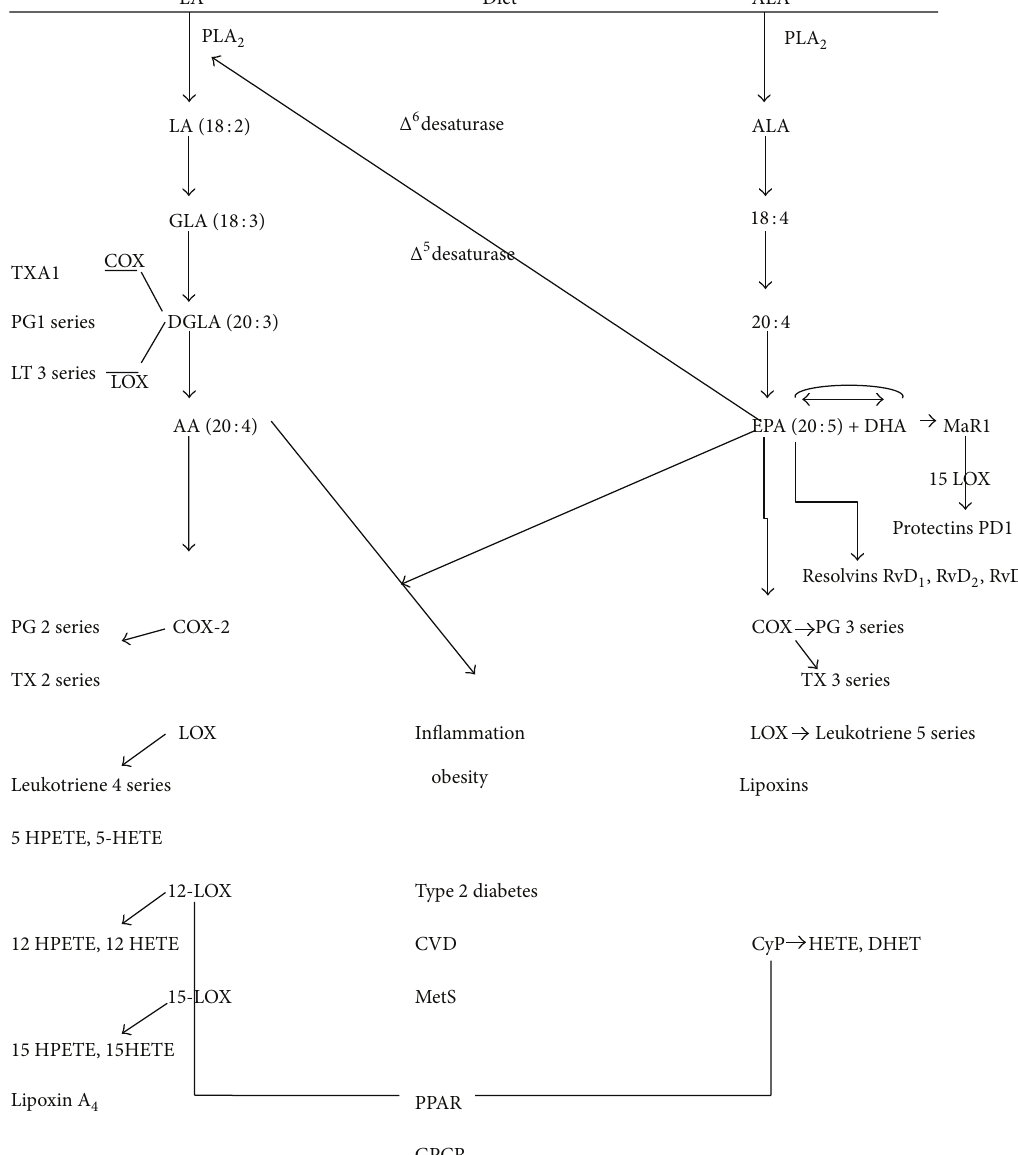
Figure 1: Major lipid influences in the inflammatory cascade. The different lipid molecules influenced by diet modulate the inflammatory cascade resulting in inflammation, obesity, cardiovascular disease, and metabolic syndrome. Dietary linoleic gets converted to the principally important proinflammatory arachidonic acid by the action of several enzymes. Further arachidonic acid by the action of COX, LOX gives rise to inflammatory responses. Linolenic acid on the other hand gets converted to eicosapentaenoic acid and docosahexaenoic acid which release anti-inflammatory resolvins, protectins, and maresins. Listed below are the abbreviations used in the figure: LA: linoleic